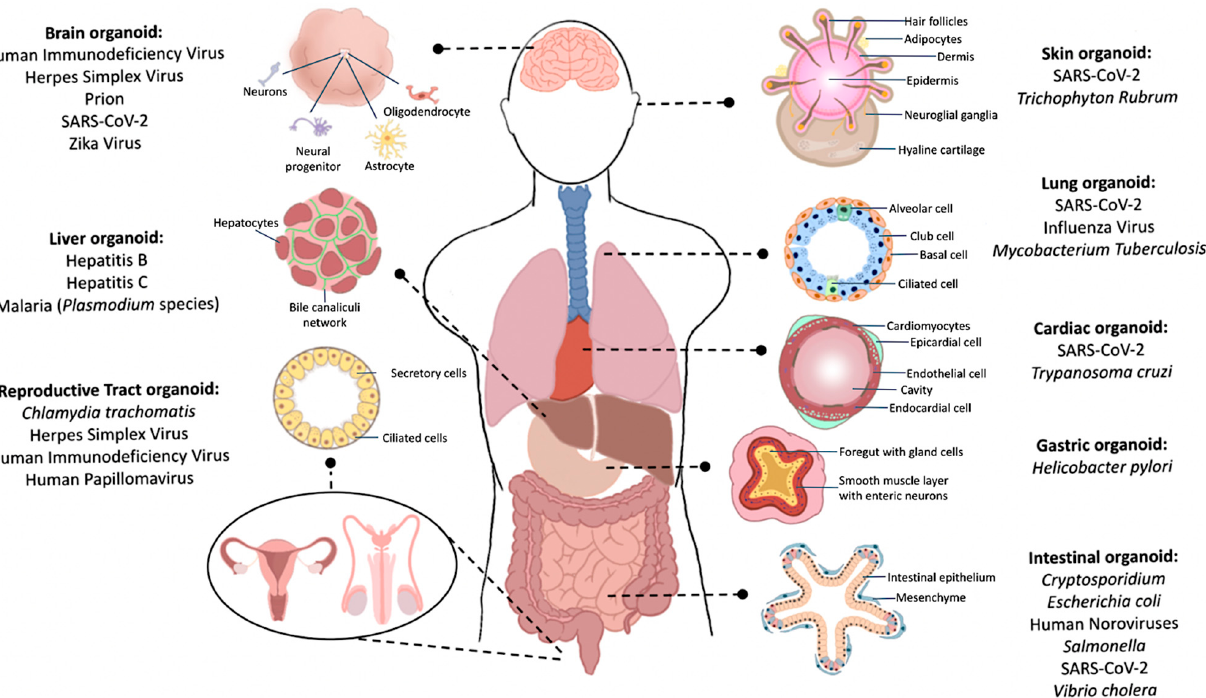
Figure 1. Common infectious diseases modelled using 3D organoids derived from human stem cells.